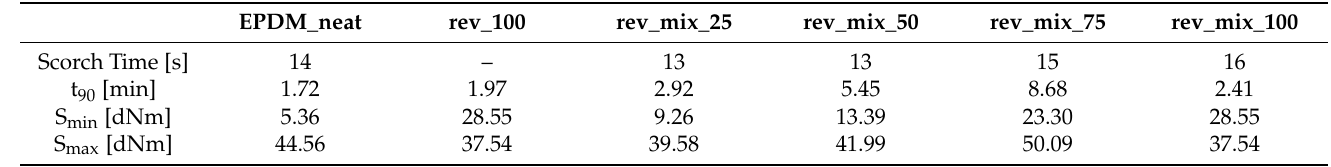
Table 6. Curing parameters of the revulcanisates.